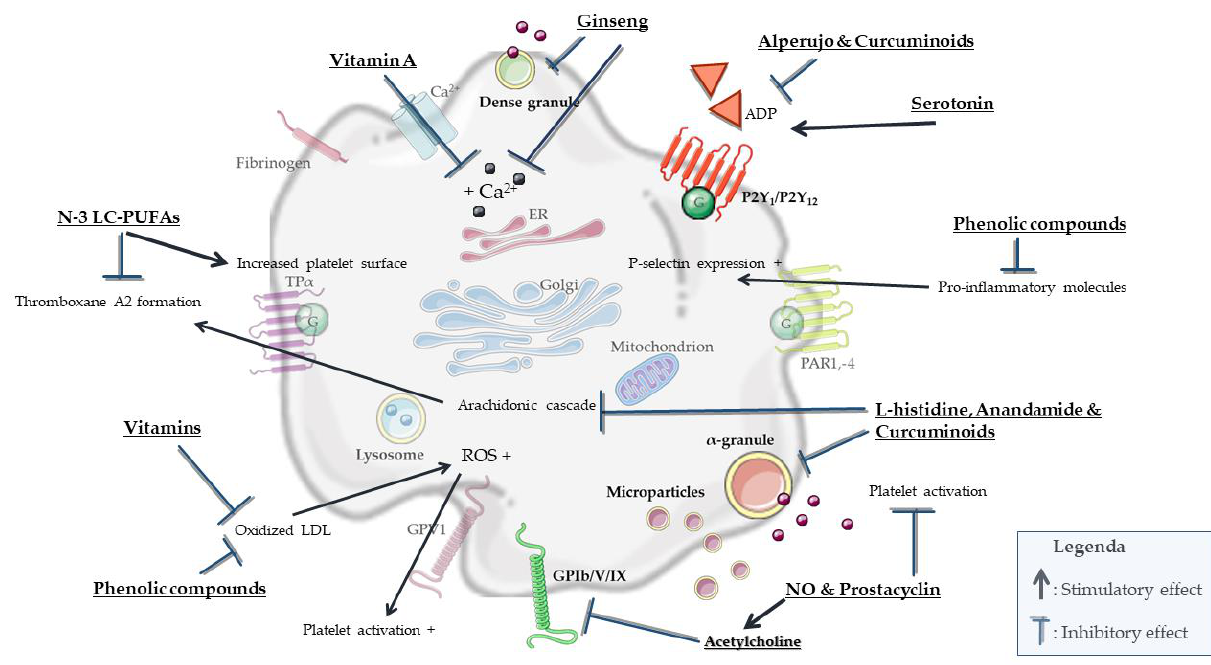
Figure 3. Schematic representation of mechanisms whereby nutritional compounds can affect platelet function.